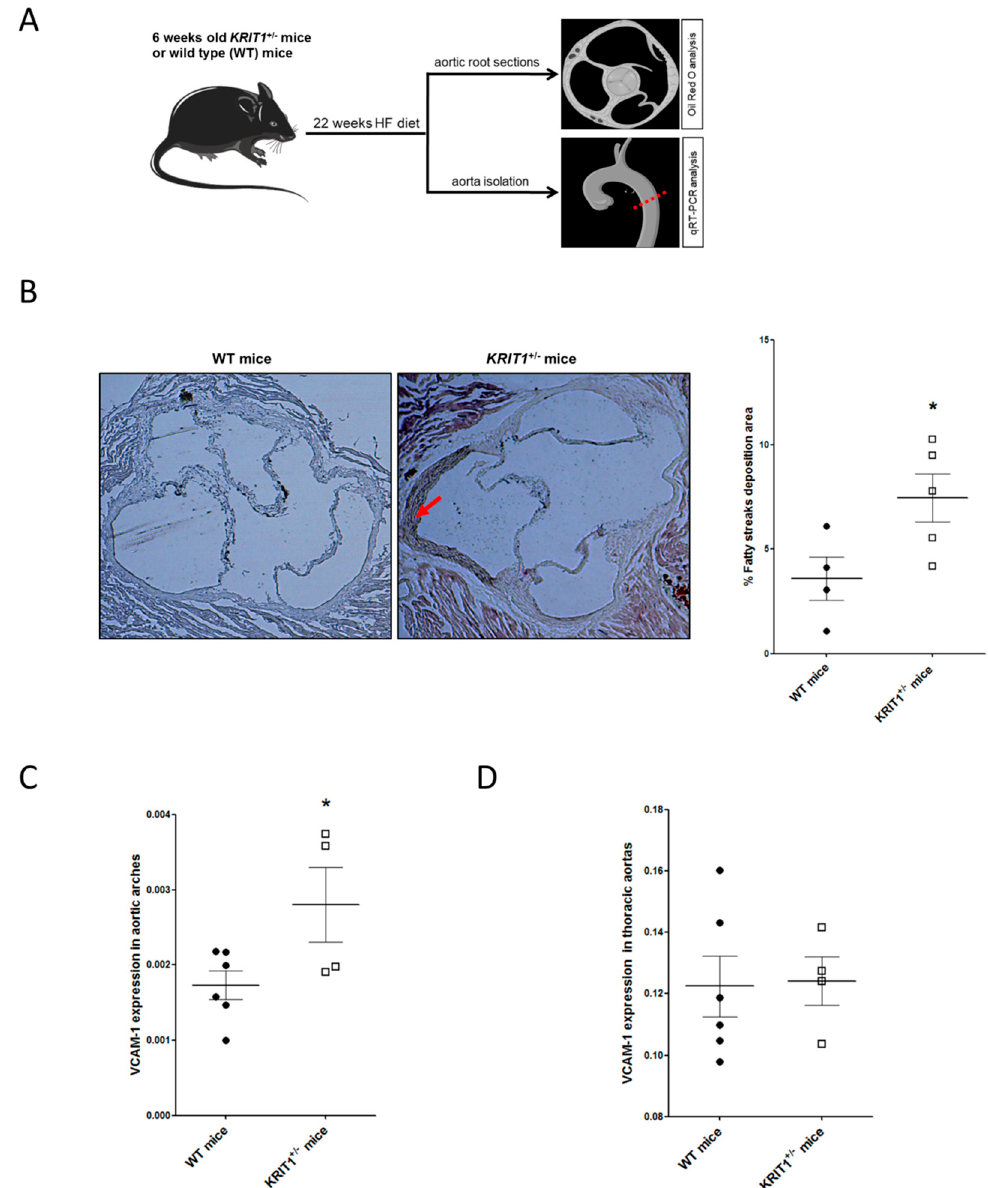
Figure 2. KRIT1 +/ − mice show an increased susceptibility to high-fructose (HF) diet-induced fatty streaks deposition and VCAM-1 upregulation in atherosclerosis-prone regions of the aorta: ( A ) Design of the animal studies: 6-week-old KRIT1 +/ − mice ( n = 6) and wild-type (WT) ( n = 6) littermates were fed a HF diet for 22 weeks, and then heart, whole aortic arches, and thoracic aortas were isolated and snap-frozen for subsequent analyses. ( B ) Representative images of lipid staining with Oil Red O in aortic root isolated from KRIT1 +/ − or WT mice fed a HF diet for 22 weeks. The red arrow indicates a prominent fatty streak. The scatter plot shows fatty streaks levels expressed as percentage of cross-sectional aortic area with fatty streaks deposition and indicated by either bold dot or square symbols for WT and KRIT1 +/ − mice, respectively. * p < 0.05. qRT-PCR analysis of VCAM-1 mRNA levels in aortic arches ( C ) and descending thoracic aortas ( D ) isolated from KRIT1 +/ − or WT mice fed a HF diet for 22 weeks. VCAM-1 mRNA levels were expressed as 2 ∆ Ct using Rpl13a as reference gene, and are indicated by either bold dot or square symbols for WT and KRIT1 +/ − mice, respectively. * p < 0.05.